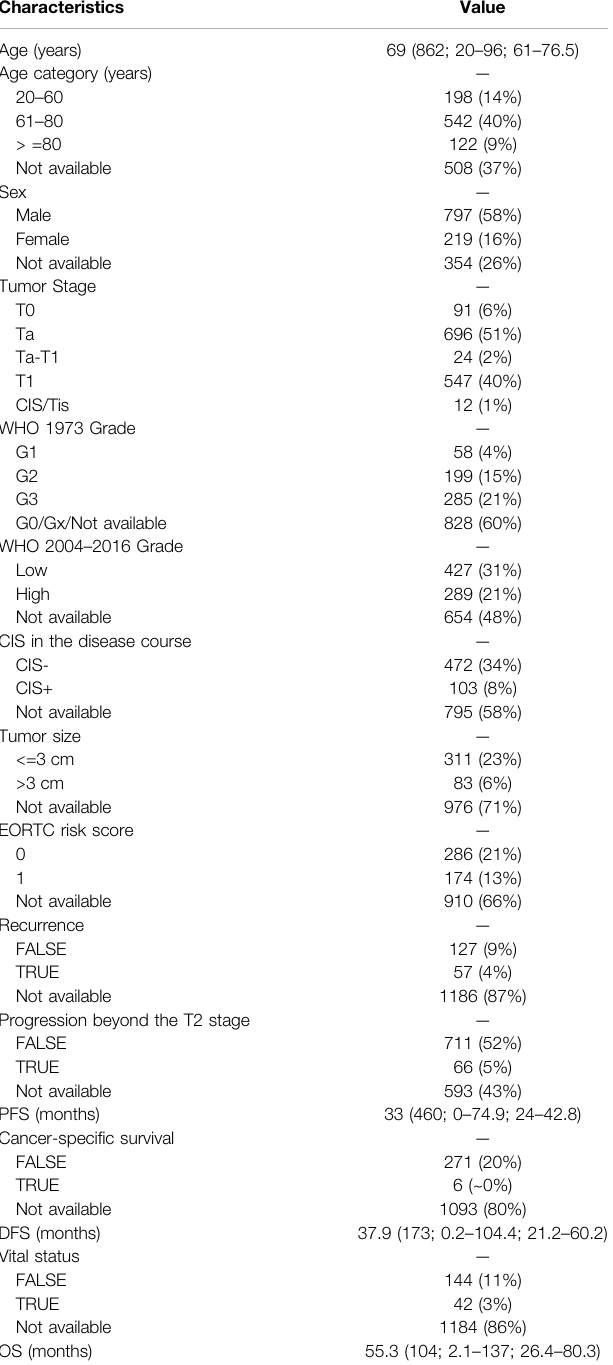
TABLE 1 | Demographic and disease characteristics of the 1,370 samples included in this study. Data are median (total number of assessable samples; range; IQR) or n (%). IQR: interquartile range. PFS: progression-free survival. DFS: disease-free survival. OS: overall